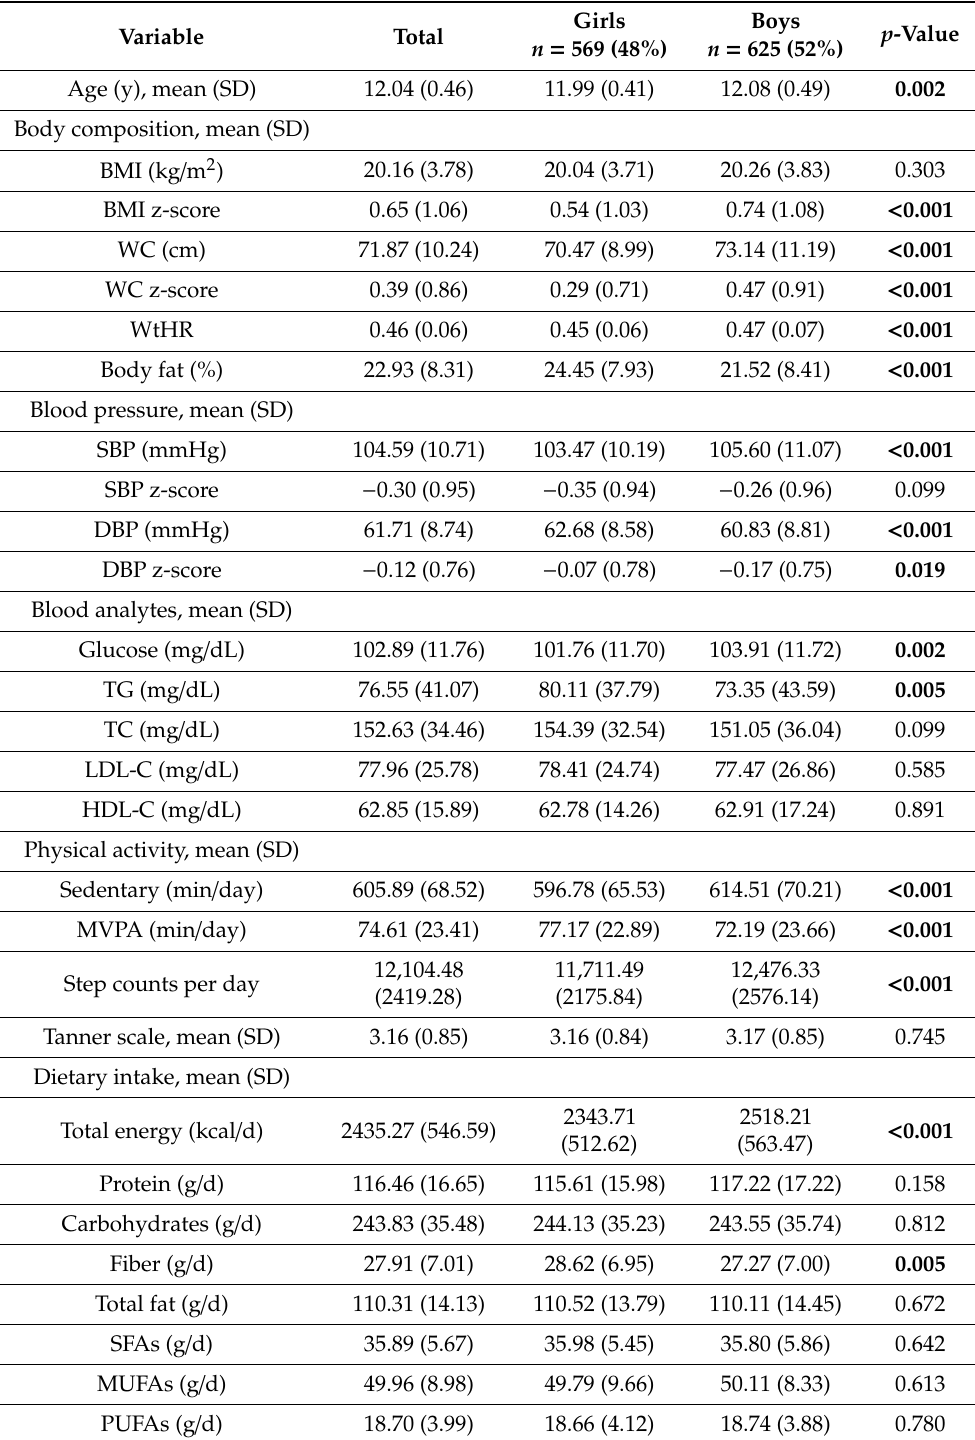
Table 1. Baseline characteristics of the study population, according to gender ( n =